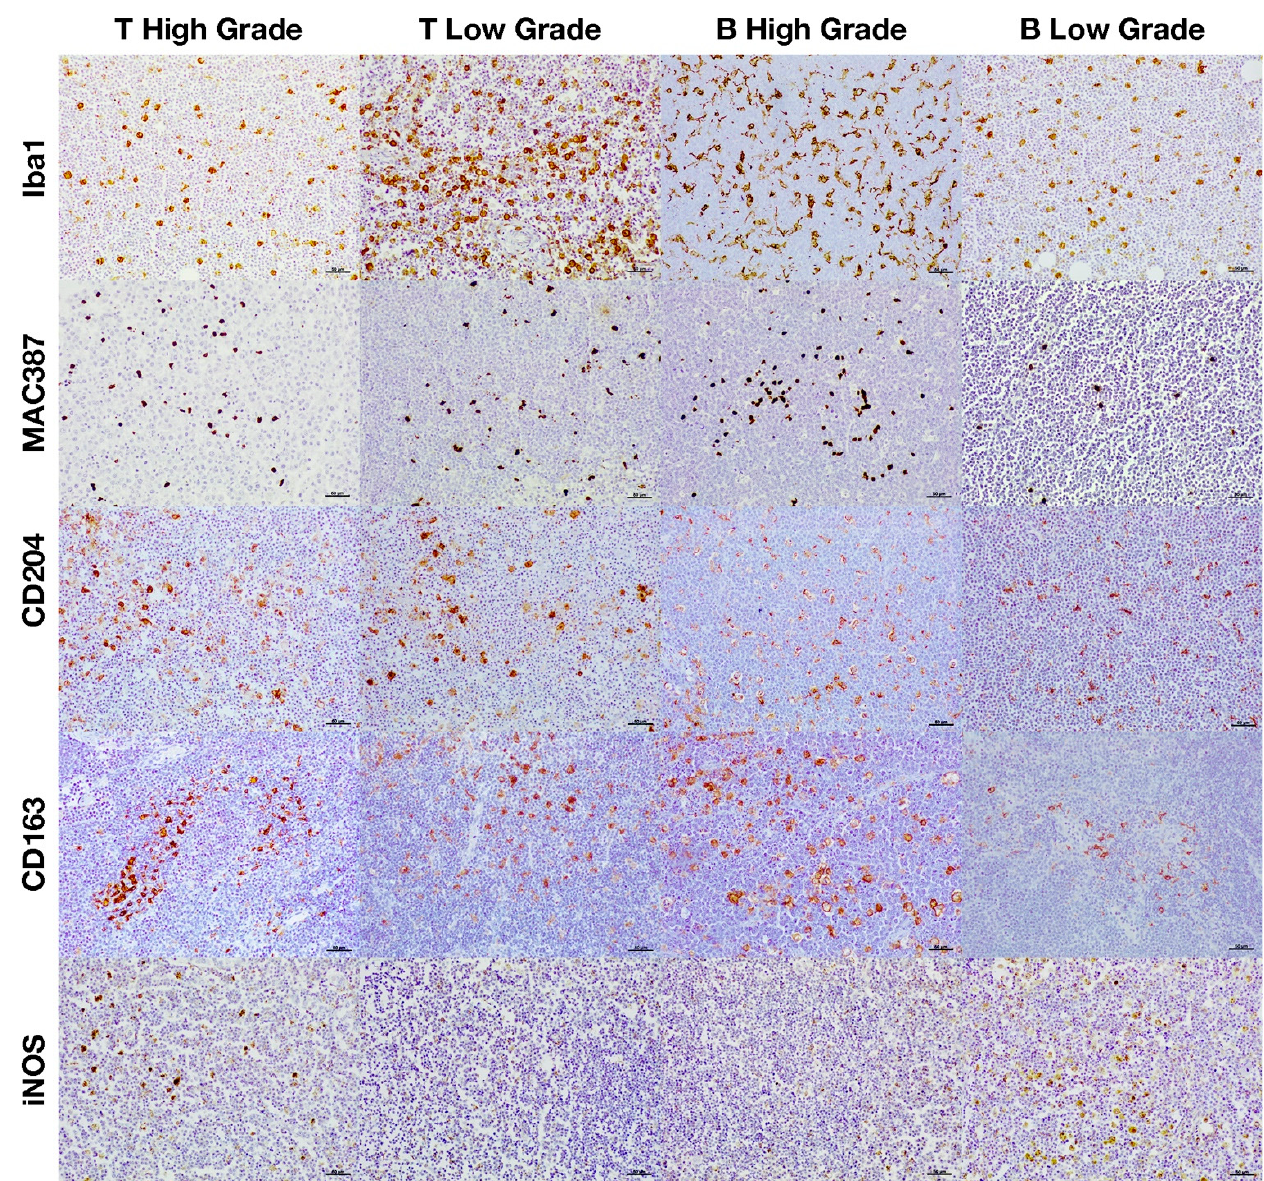
Figure 5. Immunohistochemical expression of the different macrophage markers according to both the histological grade and immunophenotype. Table 3. Spearman correlation test.